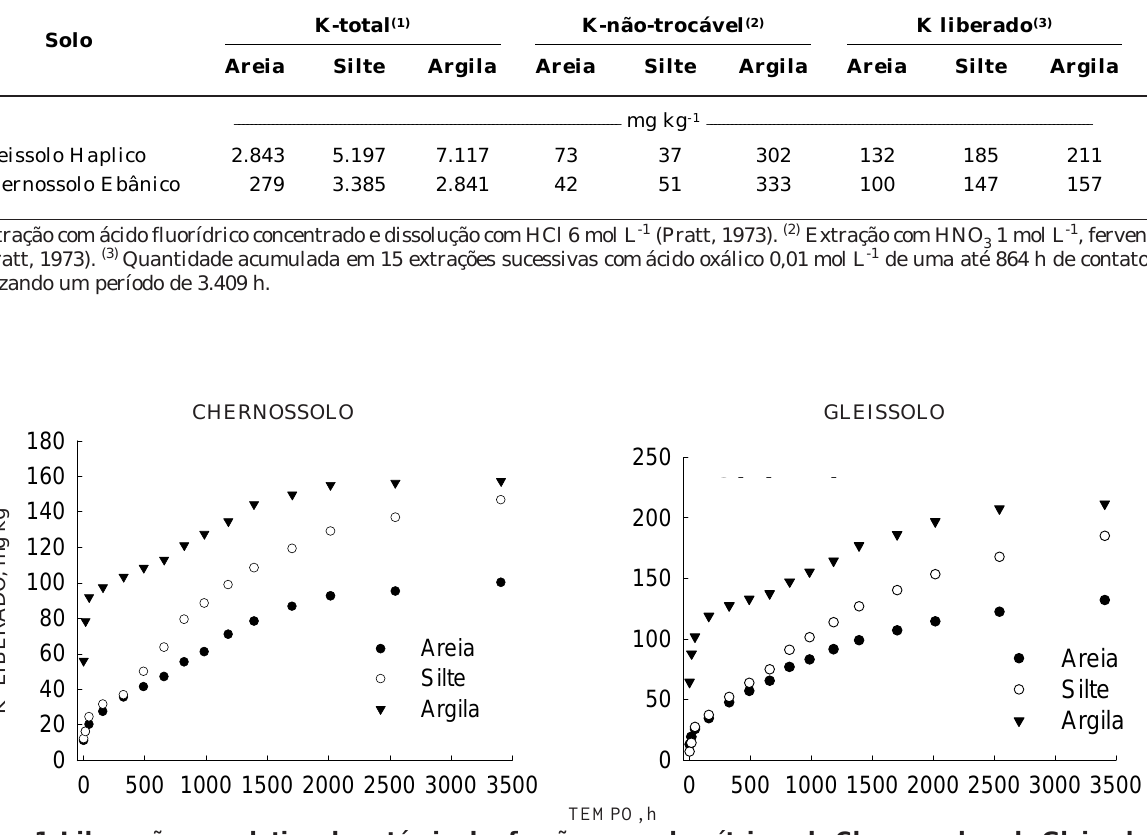
Figura 1. Liberação cumulativa de potássio das frações granulométricas do Chernossolo e do Gleissolo, considerando o